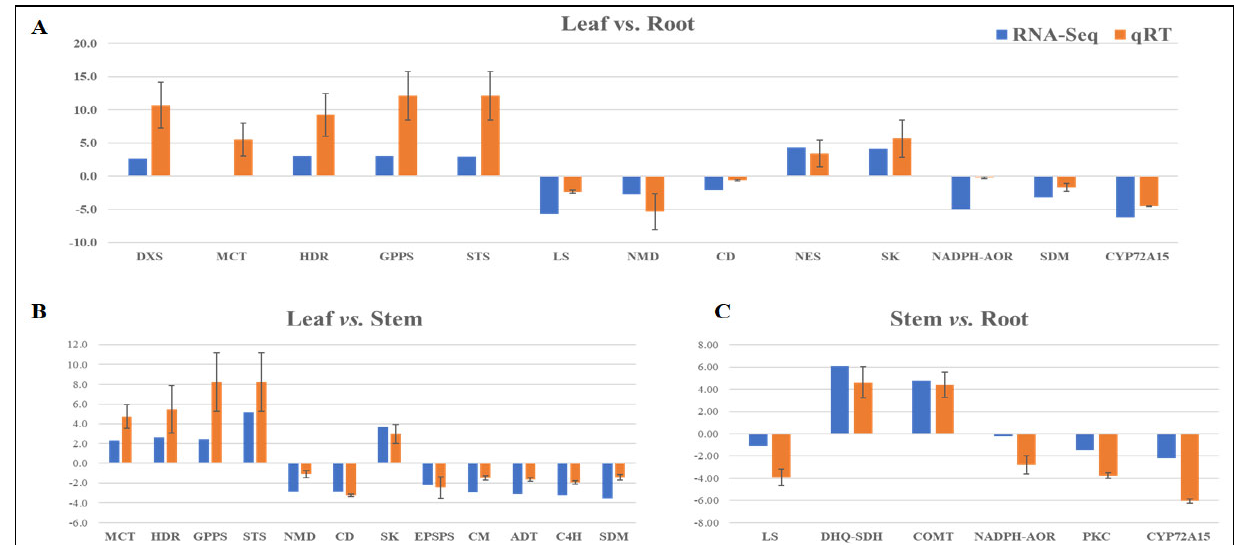
Figure 9. Representation of comparative expression profiles of genes (RNA ‐ Seq and qRT) involved in specialized ‐ metabolite ‐ biosynthesis pathways across three combinations: ( A ) leaf vs. root; ( B ) leaf vs. stem; ( C ) stem vs. root. stem; ( C ) stem vs. root.